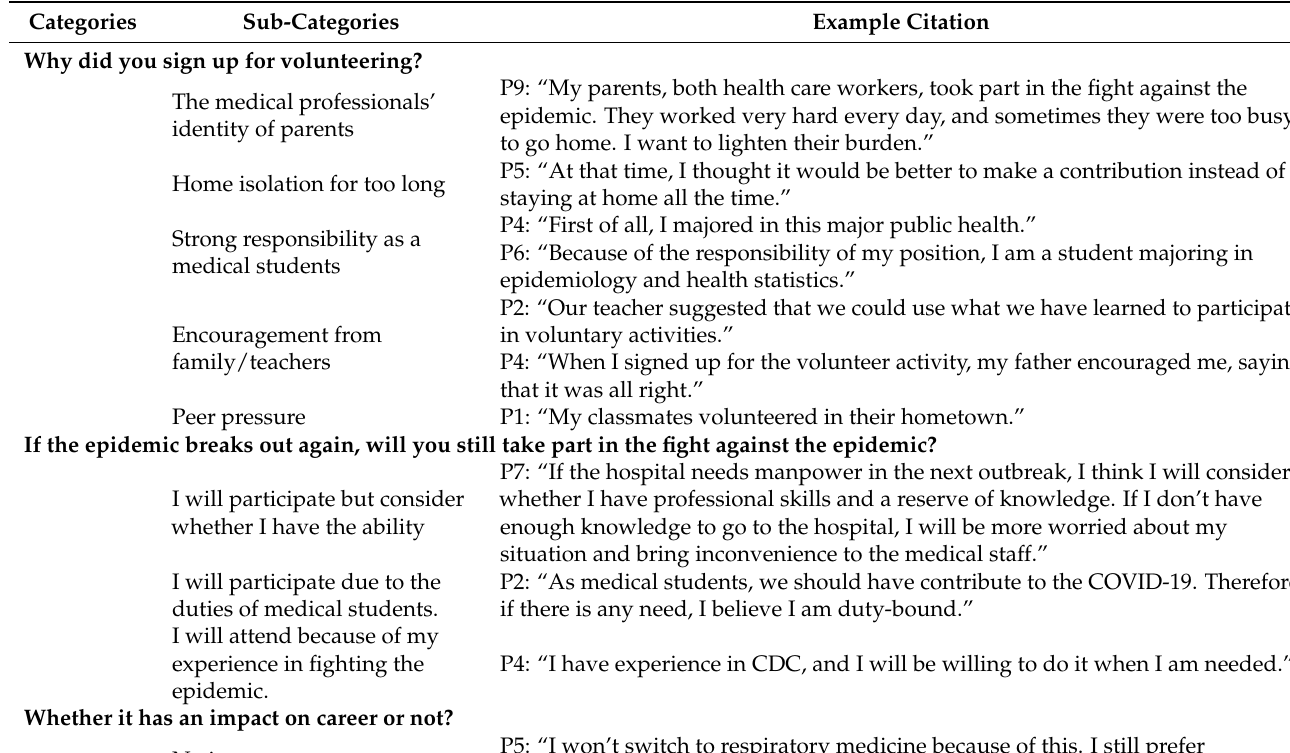
Table 4. Experience for medical student